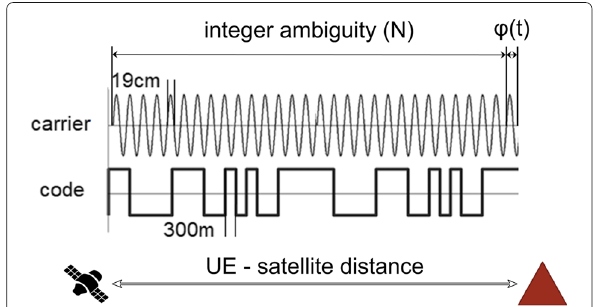
Fig. 3 Comparison between code and carrier phase measurements